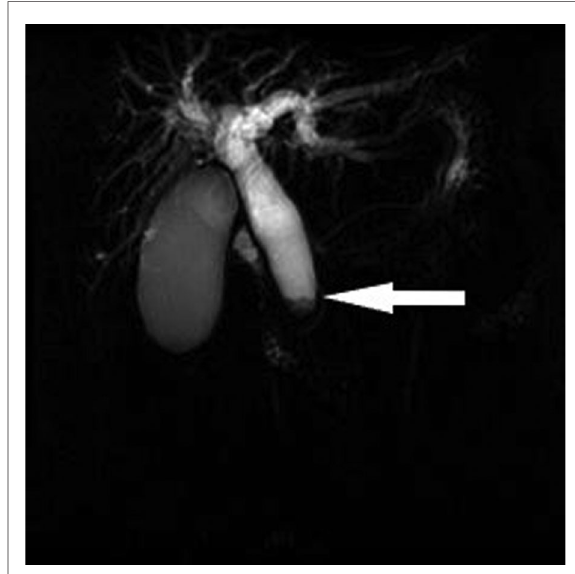
FIGURE 1 Magnetic resonance imaging showing complete obstruction of the distal bile duct (white arrow).